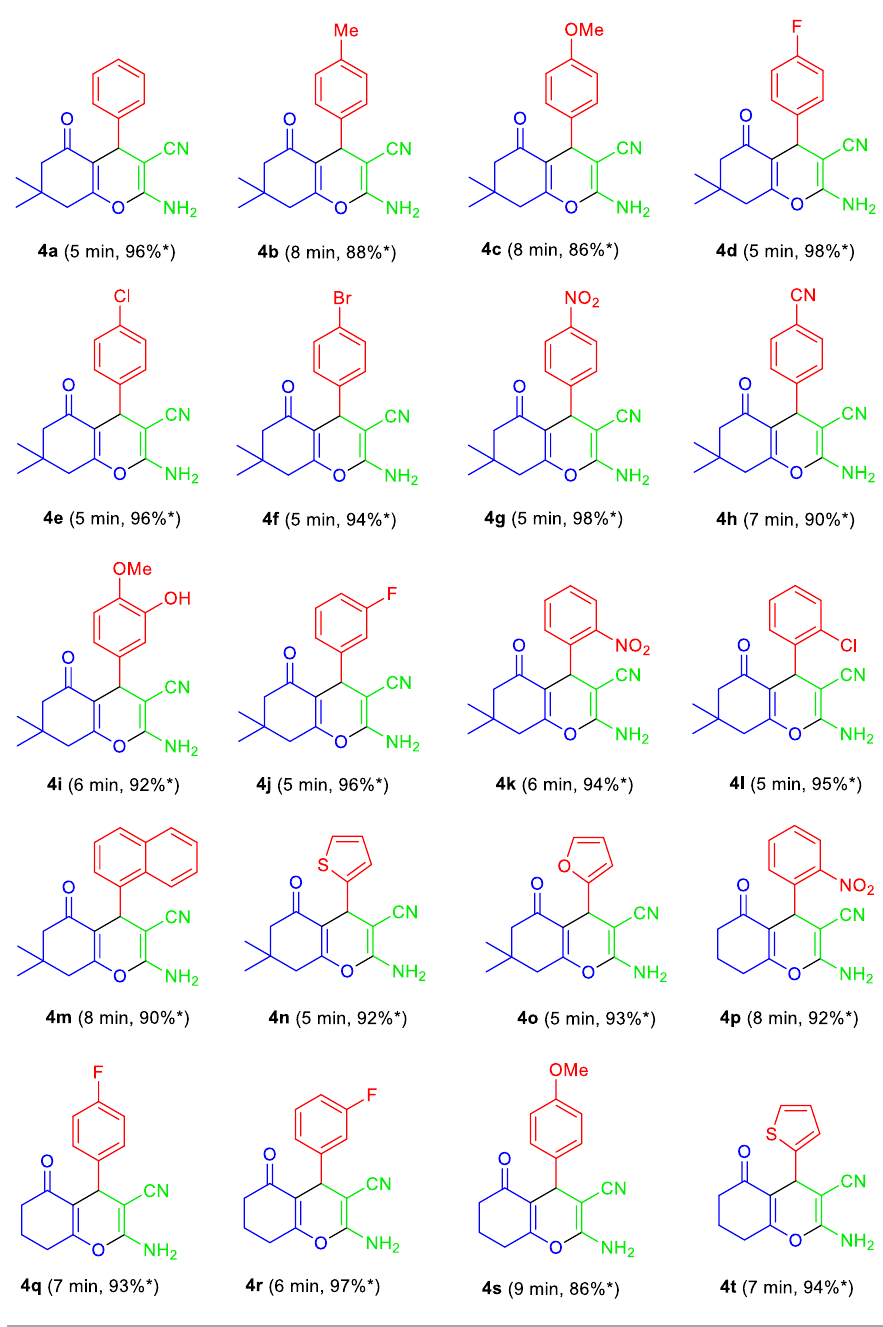
Table 2. Substrate scopes for the synthesis of 2-amino-3-cyano-4 H -chromenes derivatives 4a–t . Reaction condition: Aldehyde 1a-o (1.0 mmol), malononitrile 2a (1.0 mmol), and